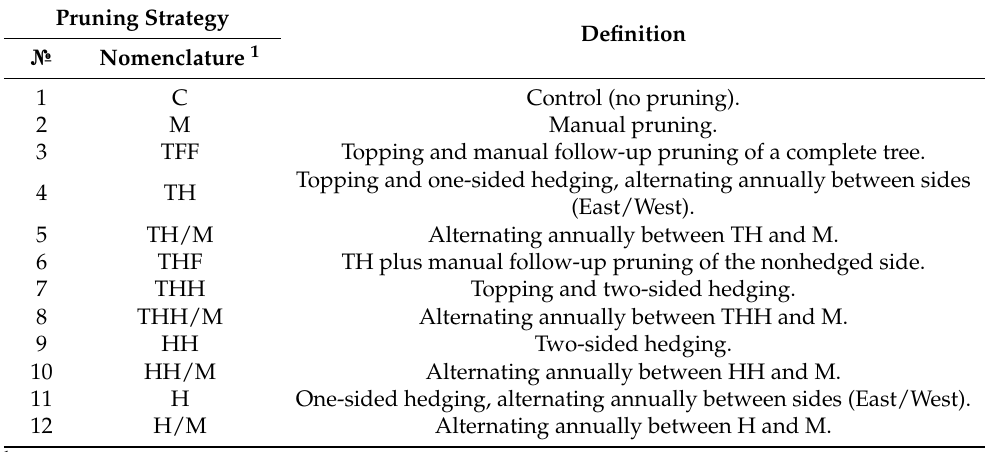
Table 1. Nomenclature and definition of pruning strategies